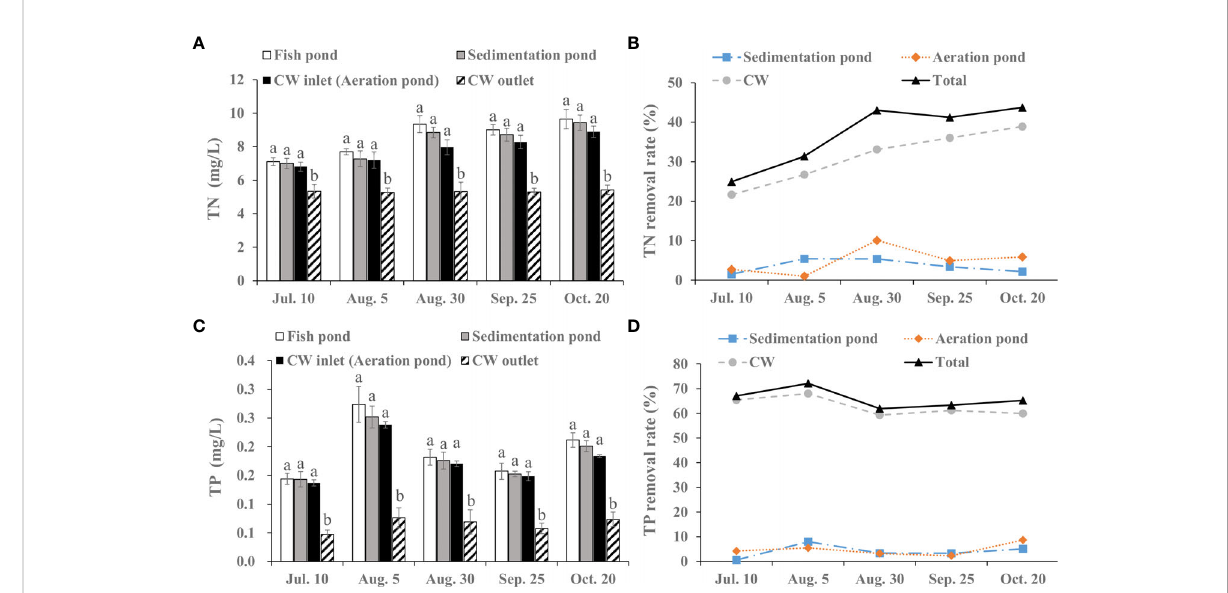
FIGURE 1 Removal ef fi ciency of integrated CW system on TN and TP during the fi sh farming period. (A) TN value in the fi sh pond, sedimentation pond, CW inlet (aeration pond) and CW outlet. (B) TN removal rate of the sedimentation pond, aeration pond and CW. (C) TP value in the fi sh pond, sedimentation pond, CW inlet (aeration pond) and CW outlet. (D) TP removal rate of the sedimentation pond, aeration pond and CW. The value is expressed as mean ± SE (n = 5). Different small letters in bar graph indicate signi fi cant difference ( p < 0.05) among fi sh pond, sedimentation pond, CW inlet (aeration pond) and CW